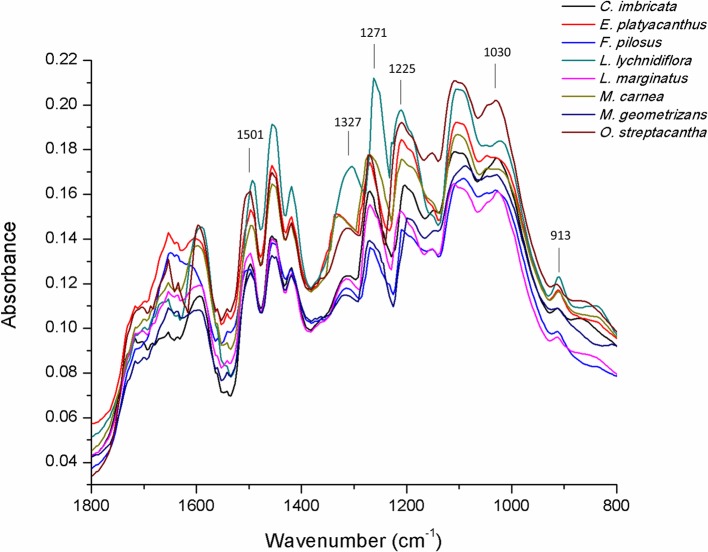
FTIR-ATR spectrum of lignin in the primary xylem of seedlings of eight Cactaceae species.